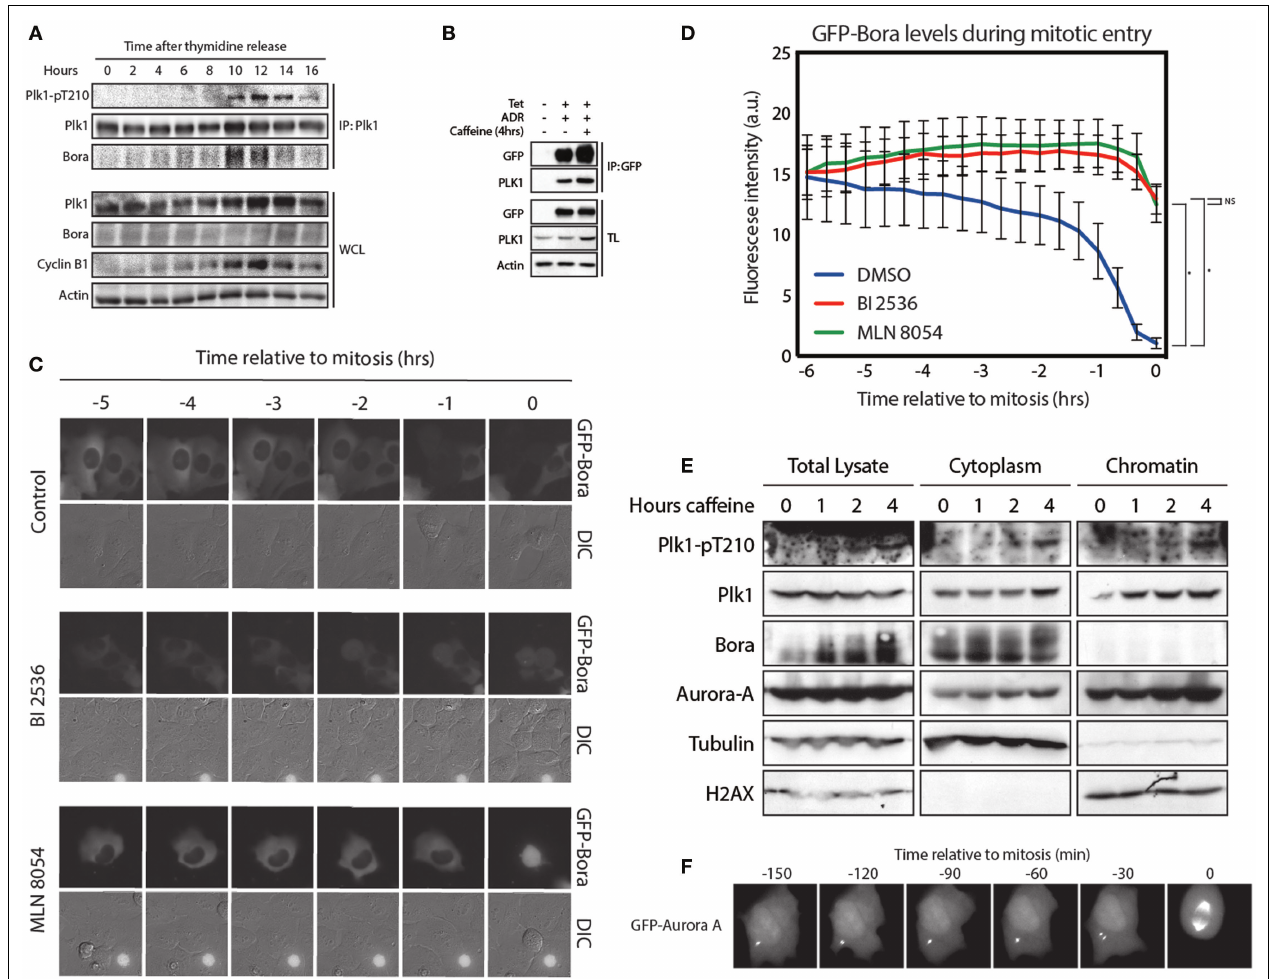
filmed asynchronously and expression was induced by tetracycline. Cells were treated as indicated with 100nM BI 2536 or 1 µ M MLN 8054. Stills from a movie showing DIC- and GFP-images are shown of cells entering mitosis. (D) Quantification of 3C, total GFP expression levels were measured over time. Error bars represent SEM of 10 individually quantified cells. * p < 0.0001. (E) U2OS cells were arrested for 16h after induction of DNA damage in G2 with 0.5 µ M adriamycin. Recovery was induced with caffeine for the indicated times. Total lysates were obtained as well as cytoplasmic and chromatin fractions using the cell fractionation protocol from Méndez and Stillman (21). (F) Stills from real time imaging of a GFP-Aurora A-expressing U2OS cell entering mitosis.